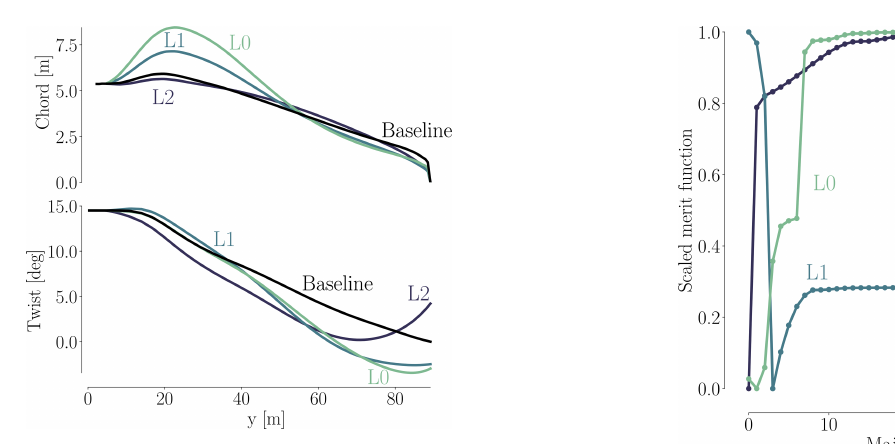
Figure 12. Scaled merit function history for the CFD-based plan- form